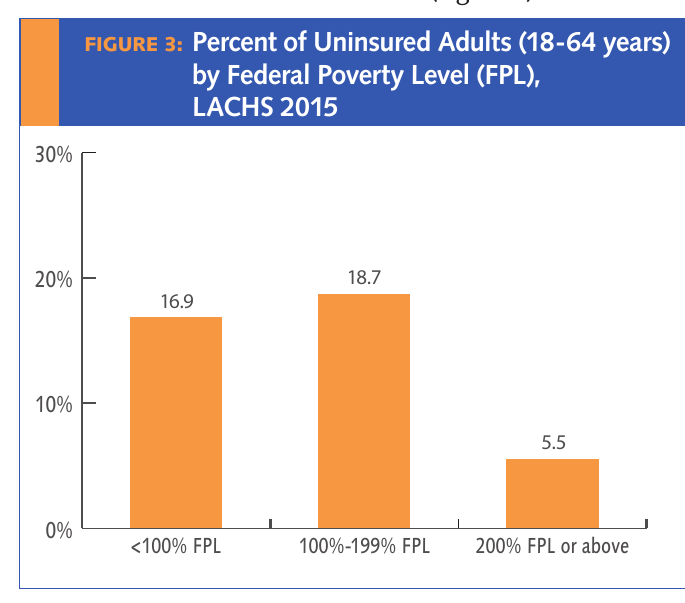
FIGURE 3: Percent of Uninsured Adults (18-64 years) by Federal Poverty Level (FPL), LACHS